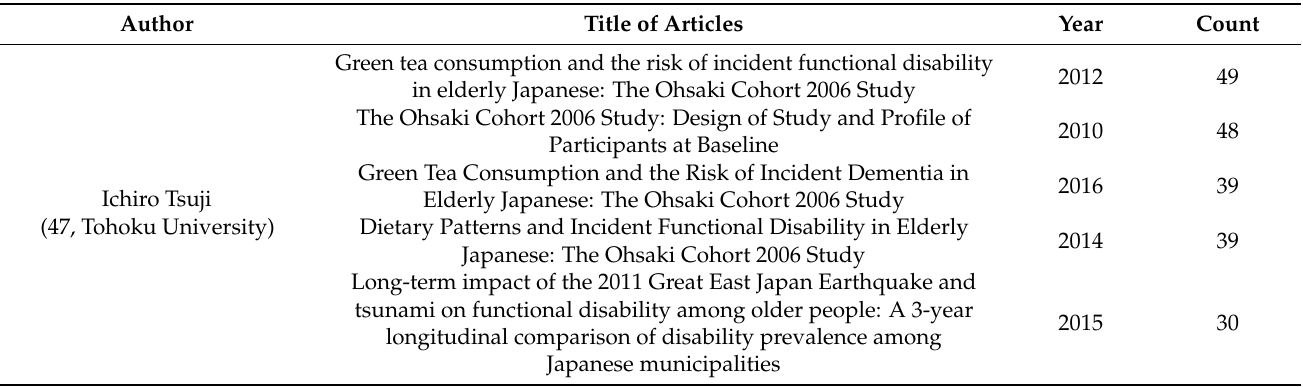
Table 3. Top five most cited articles from Tsuji.